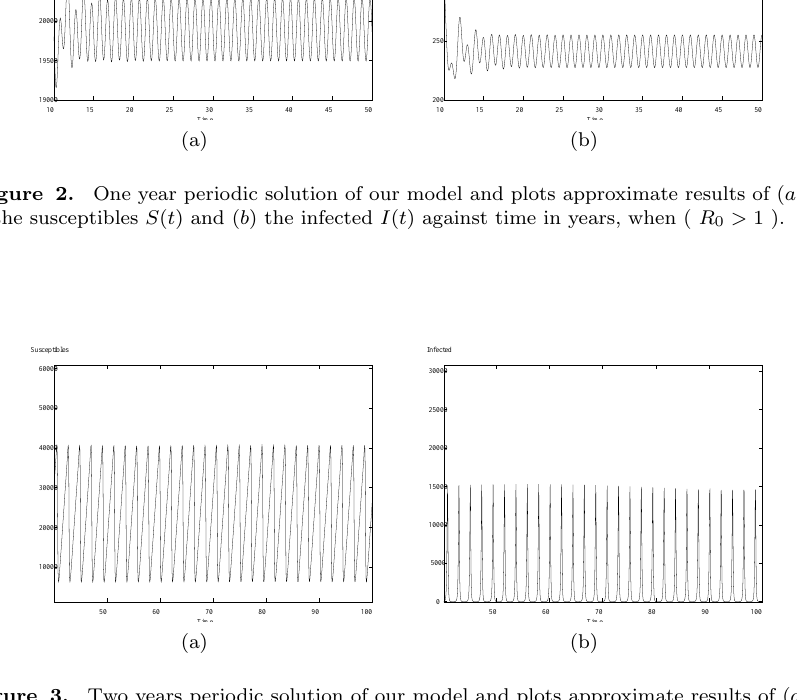
Figure 3. Two years periodic solution of our model and plots approximate results of ( a ) the susceptibles S ( t ) and ( b ) the infected I ( t ) against time in years, when R 0 >